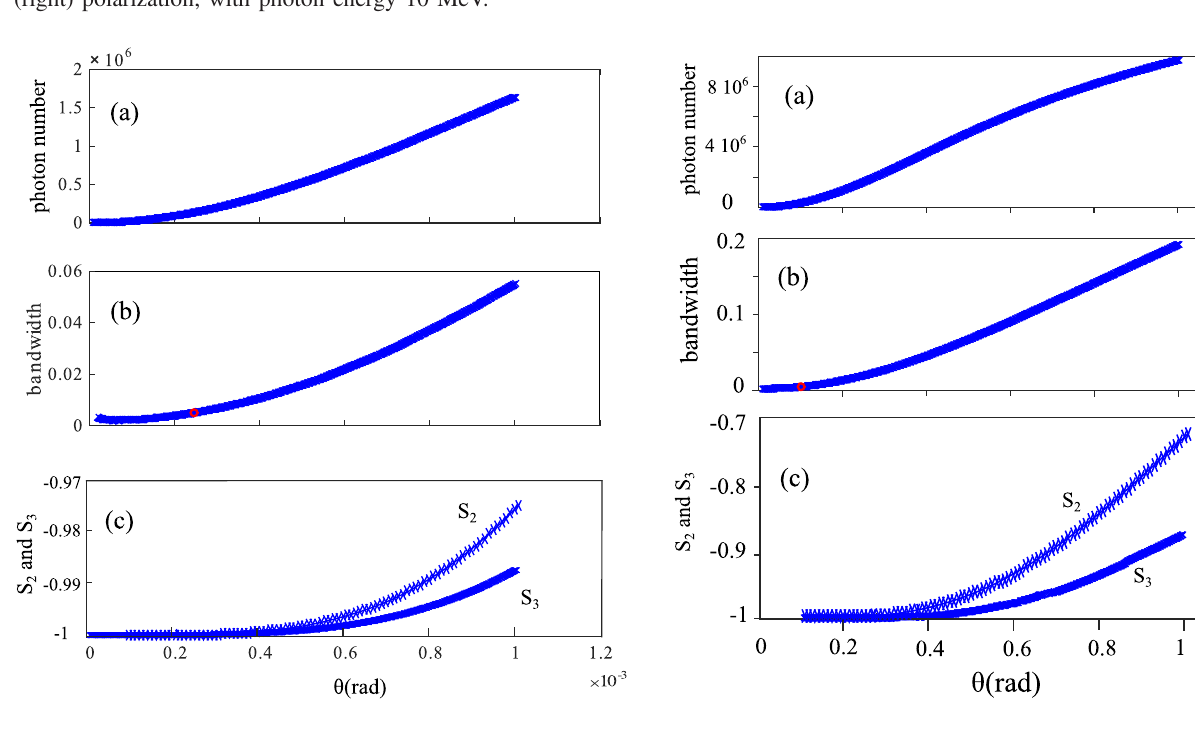
FIG. 8. ELI-NP case (beam3) (a) Photon number, (b) relative bandwidth, and (c) Stokes parameters for gamma rays at 10 MeV (beam 3), linear and circular laser